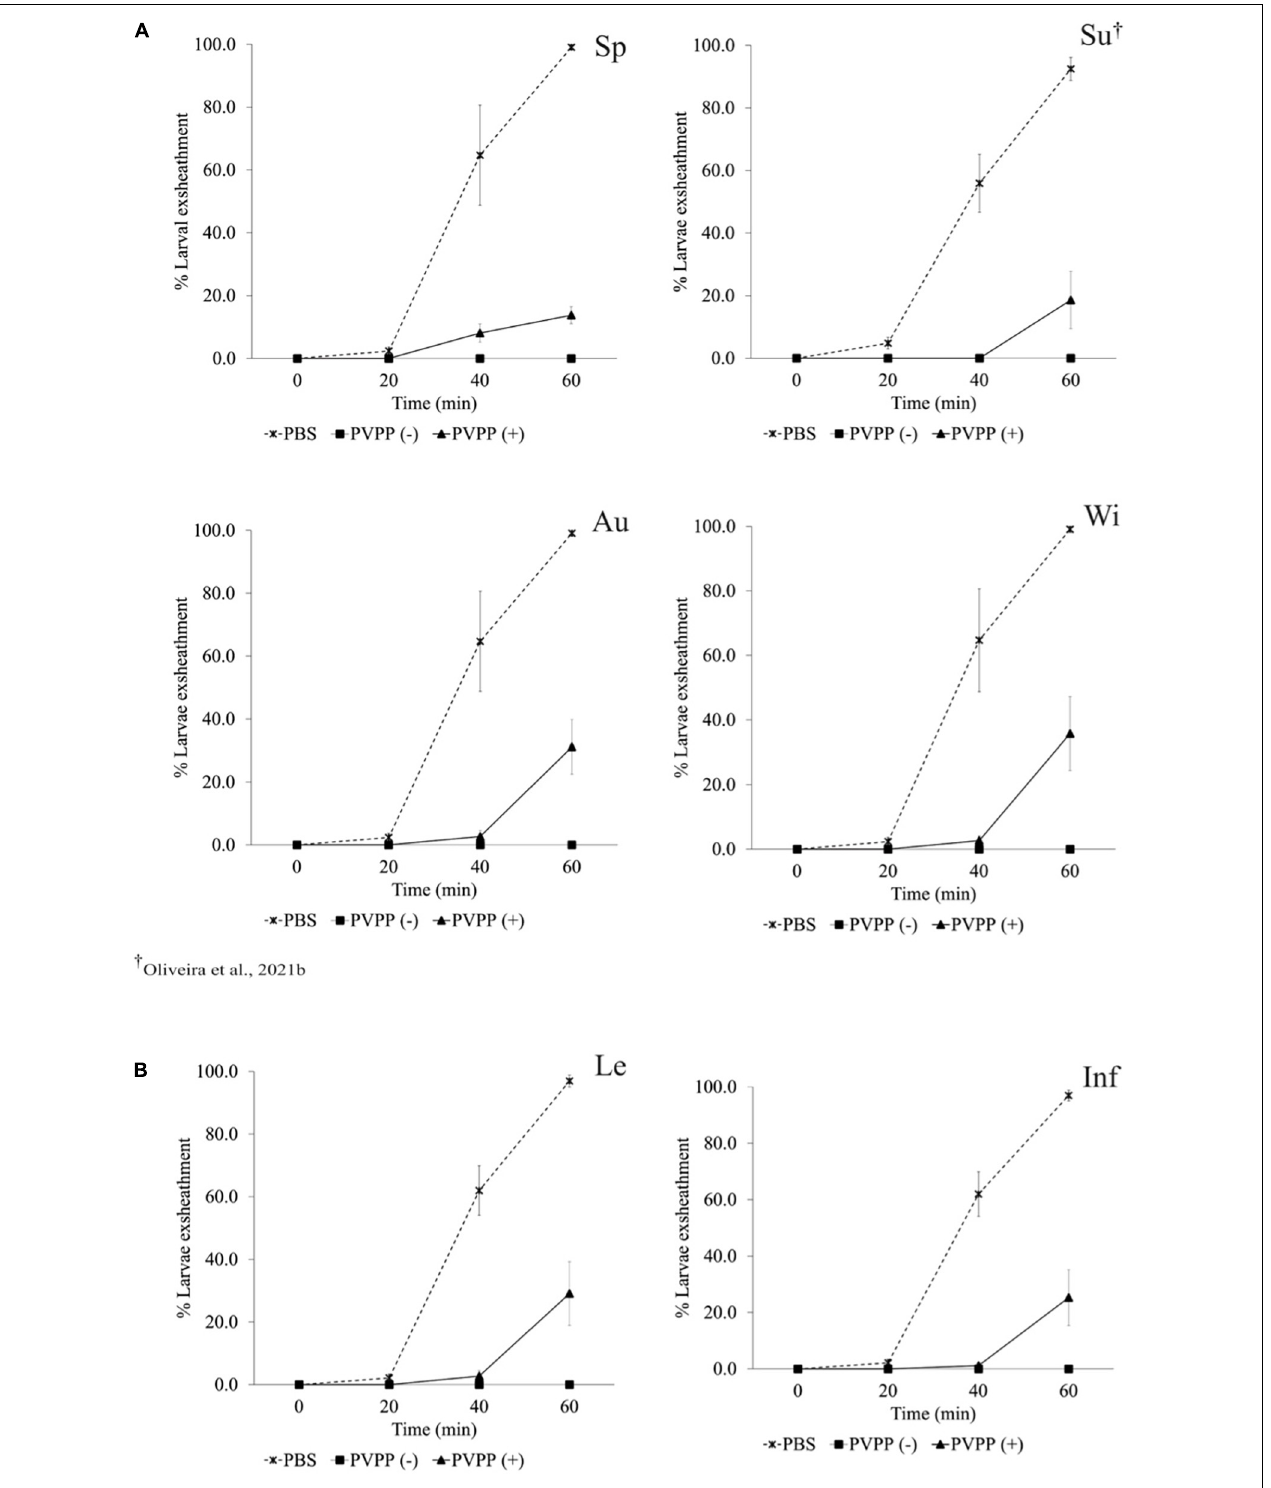
FIGURE 3 | Anthelmintic effects of Cladium mariscus (L.) Pohl (sawgrass) seasonal (A) and organ (B) extracts, on LEIA for Trichostrongylus colubriformis at the concentration of 1,200 µ g mL − 1 , either treated [PVPP(+)] or not [PVPP(-)] with PVPP. Sp, spring; Su, summer; Au, autumn; Wi, winter; Le, leaves; Inf, inflorescences.